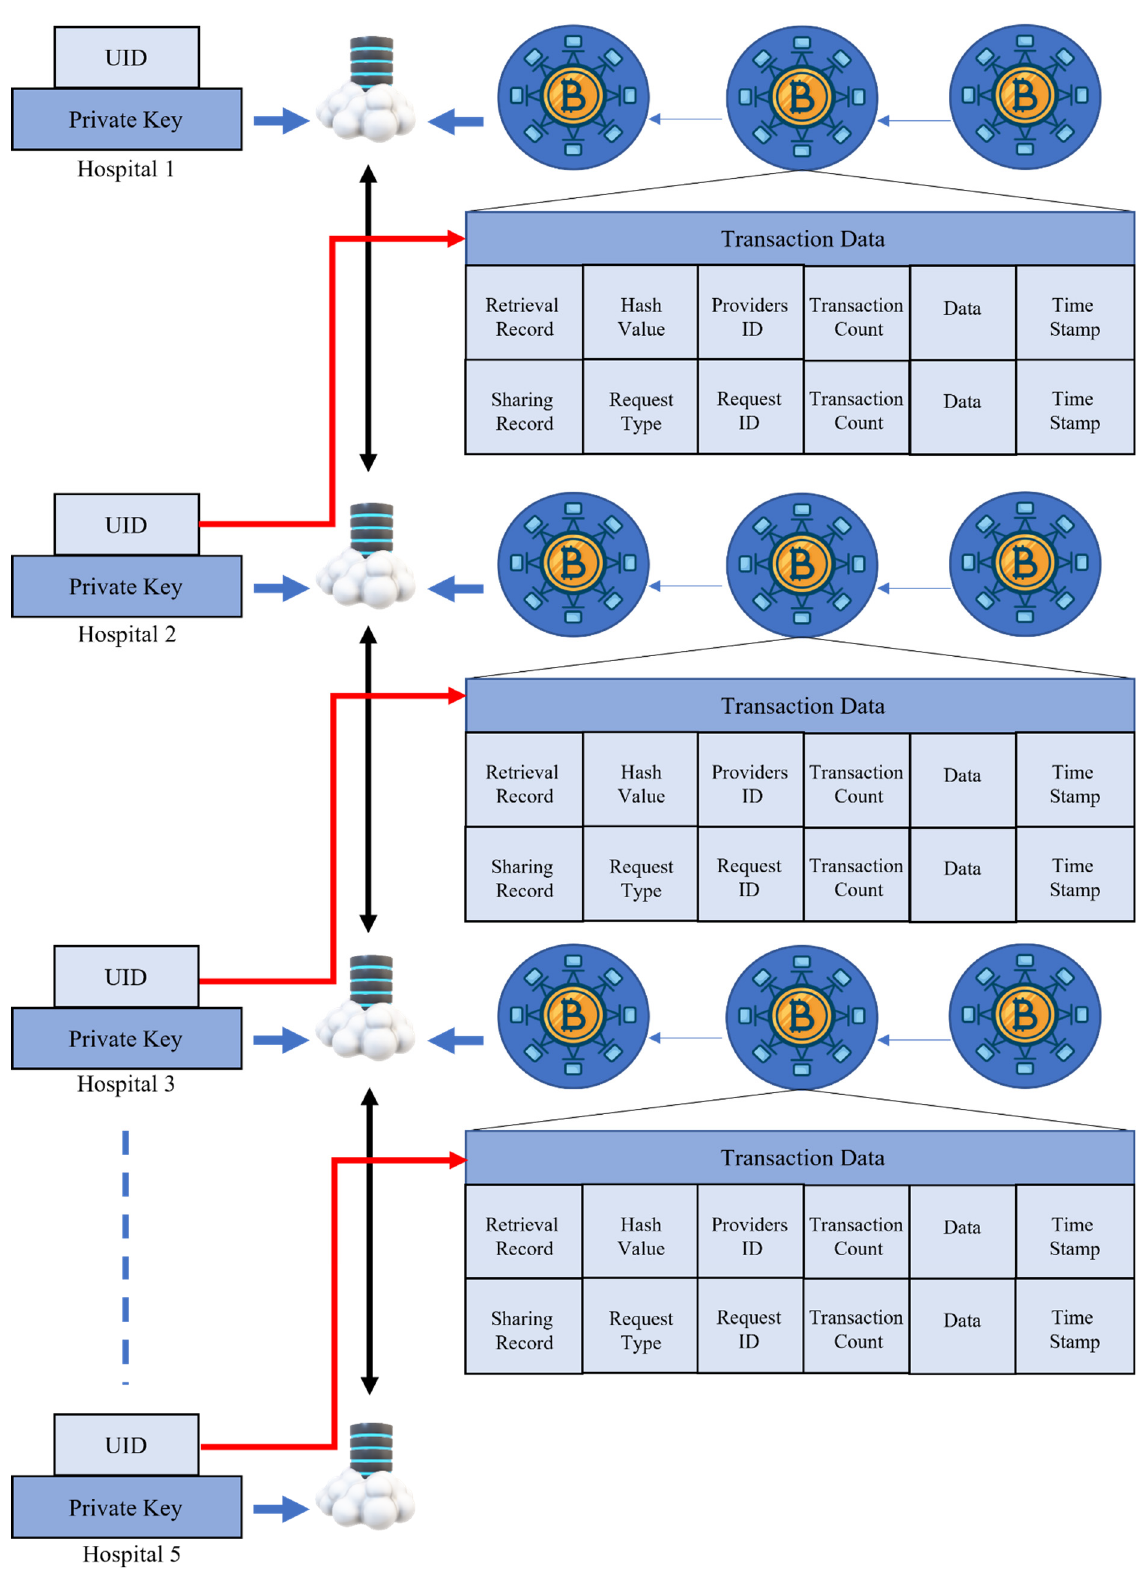
Figure 4 . Procedure of keeping medical records on blockchain across five distinct hospitals. Figure 4. Procedure of keeping medical records on blockchain across five distinct